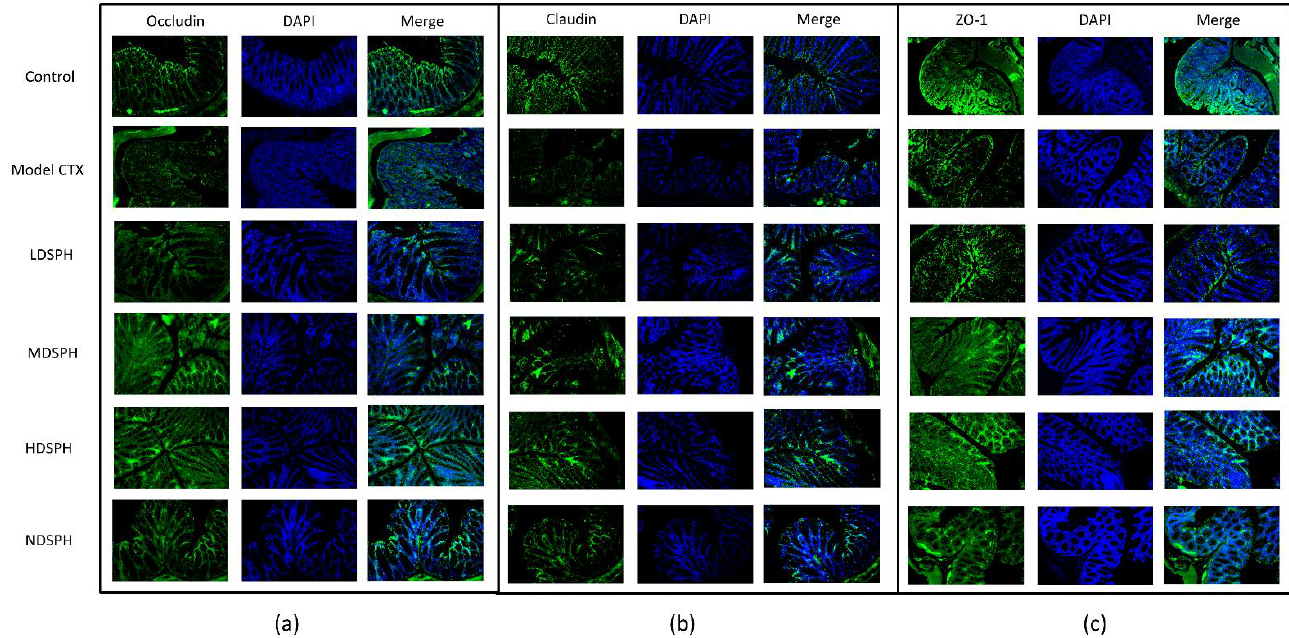
Figure 8. Mucin-2 immunohistochemistry staining in the colon of various groups Mucin expression (demonstrated by black arrows) and inflammatory cells are shown (demonstrated by red arrows), Original magnification 10×, 20×, scale bar: 100 µm.